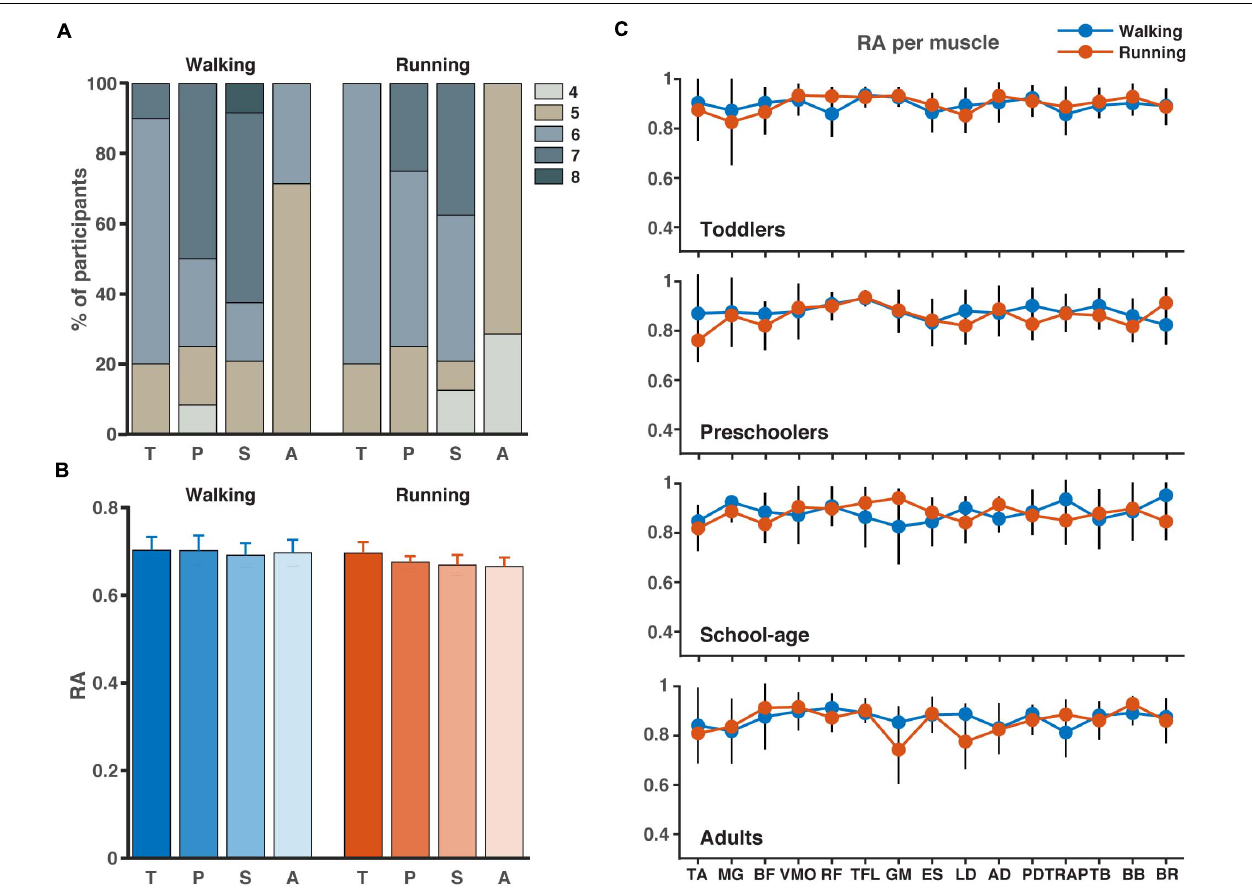
FIGURE 3 | Number of synergies and accuracy. (A) Number of synergies needed to account for the cycle-to-cycle variability of EMG activity during walking and running for each group as determined by principal component analysis PCA ( > 80% of variance). (B) The corresponding reconstruction accuracy (RA) after rank-reduction with PCA followed by NMF. (C) The RA (mean SD) for each muscle and condition (blue = walking, red = running). TA, tibialis anterior; MG, medial gastrocnemius; BF, biceps femoris; VMO, vastus medialis oblique; RF, rectus femoris; TFL, tensor fascia latae; GM, gluteus maximus; ES, erector spinae; LD, latissimus dorsi; AD, anterior deltoid; PD, posterior deltoid; TRAP, trapezius; TB, triceps brachii; BB, biceps brachii; BR, brachioradialis; T, toddlers; P, preschoolers; S, school-age; A,